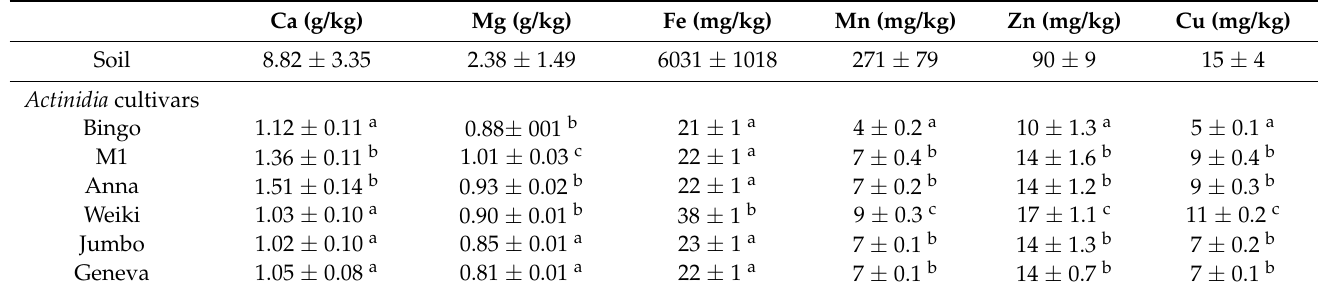
Table 1. Mineral element contents in soil and six cultivars of kiwiberry fruits (DM basis); mean ± SD. Ca (g/kg)